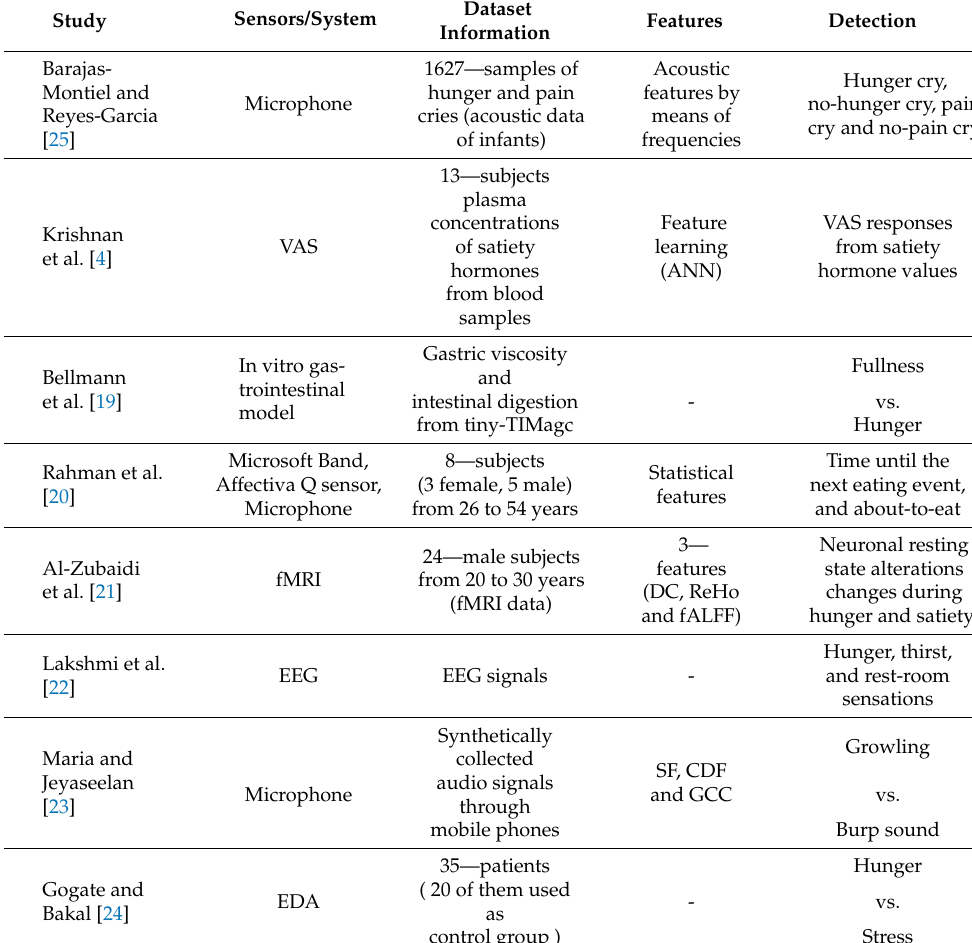
Table 1. Sensors and systems for the assessment of hunger in the